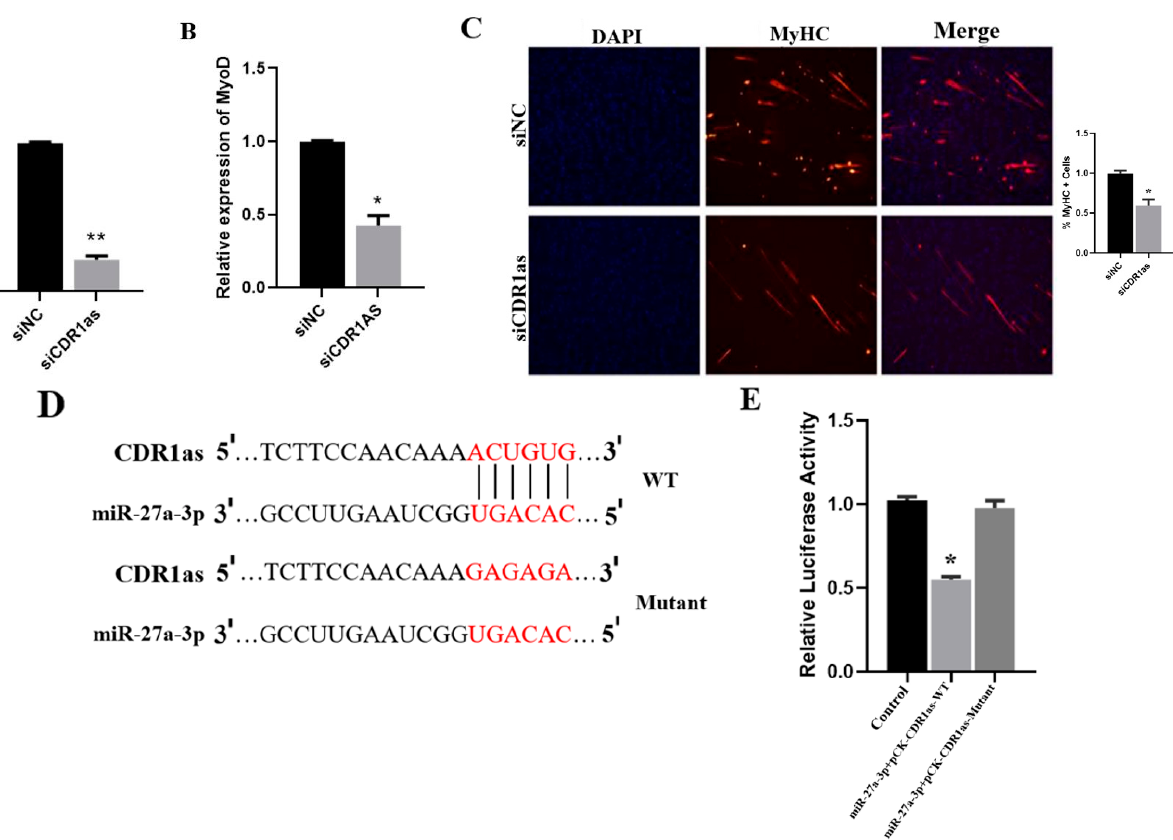
Figure 5. siCDR1as inhibits ANGPT1 via upregulation of miR-27a-3p. ( A ) Validation of the RNA expression levels of CDR1as in SMSCs transfected with siCDR1as. ( B ) RNA expression levels of MyoD after transfecting with siCDR1as. ( C ) MyHC immunofluorescence was decreased during siCDR1as. ( D ) The binding site analysis between CDR1as and miR-27a-3p . ( E ) Relative Lucif- erase activity of putative miR-27a-3p to pCK-CDR1as-WT/Mutant. ( F ) SMSCs transfected with siCDR1as+miR-27a-3p, cell differentiation was detected by immunofluorescence (MyHC) and MyHC positive cells. The number of ‘’*’’ indicates the level of significance. **, p < 0.05, *, p < 0.01. The p values were analyzed by Student’s t -test; p < 0.05. 4. Discussion Recent studies indicate that muscle development is associated with several coding and non-coding genes, including circRNAs, miRNAs, and mRNAs [19]. For instance, circFGFR4 induces myoblast differentiation through the upregulation of Wnt3a via the downregulation of miR-107 [38]. Moreover, circSVIL inhibits miR-203 by increasing the expression level of MEF2C during muscle differentiation [37]. Therefore, studying the transcriptomic view of CDR1as, its regulatory mechanism associated with miR-27a-3p, and ANGPT1 during muscle differentiation in SMSCs, may contribute to the understand- ing of genes involved in myogenesis. In this study, we found that upregulation of miR- 27a-3p by siCDR1as decreases SMSCs differentiation through the downregulation of ANGPT1. CDR1as functions in tumors and cancer have been extensively studied [39–41]. We previously confirmed that CDR1as promotes the myogenic differentiation of SMSCs [5]. However, there is limited knowledge about CDR1as in muscle development. Besides, the